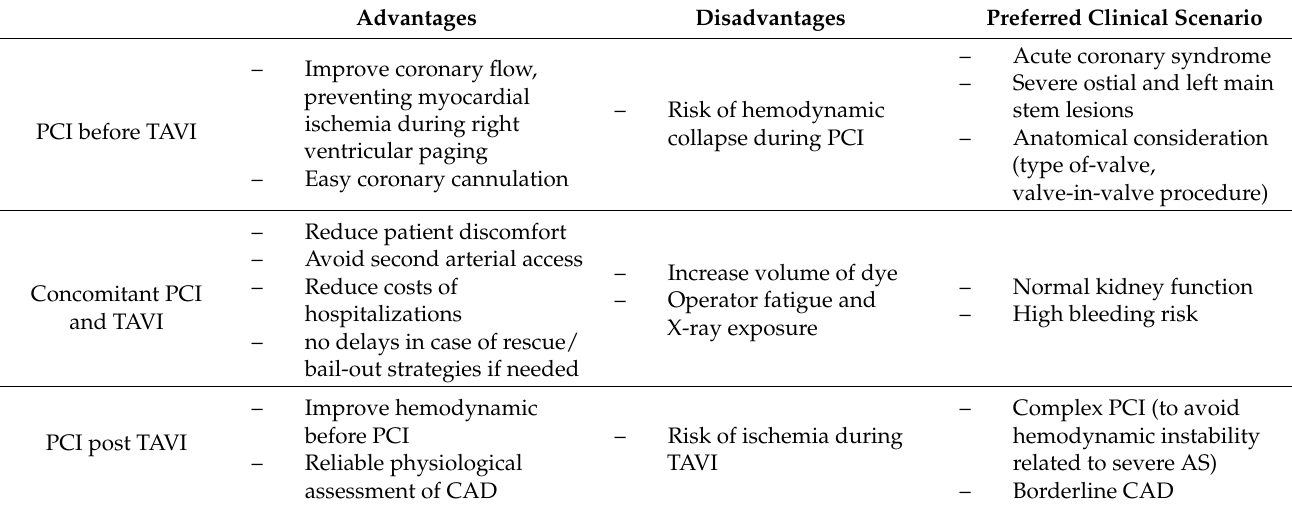
Table 4. Timing of PCI in relation to